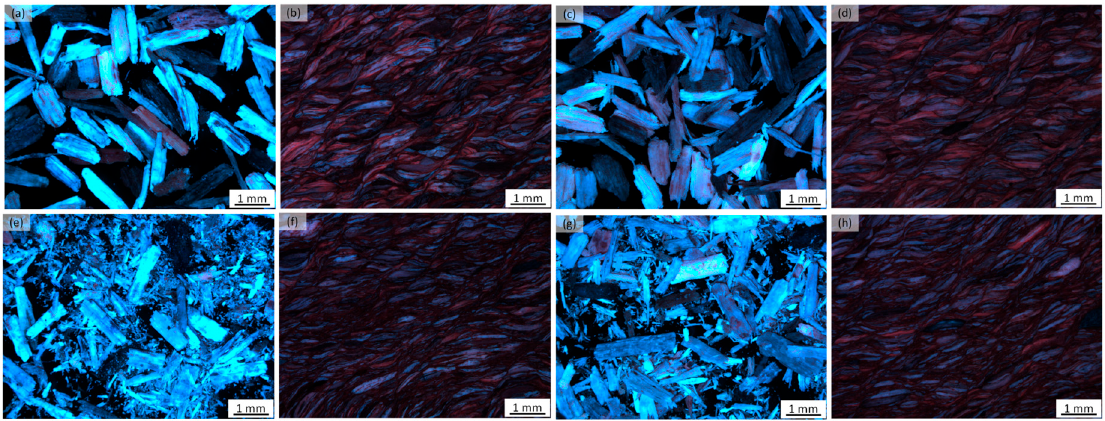
Figure 6. Fluorescence overlay images of HW / PEI / TA particles before ECAP (left) and consolidated biocomposites after ECAP (right): ( a , b ) with no pre-treatment, ( c , d ) with alkali pre-treatment, ( e , f ) with ball milling, and ( g , h ) with alkali + ball milling.